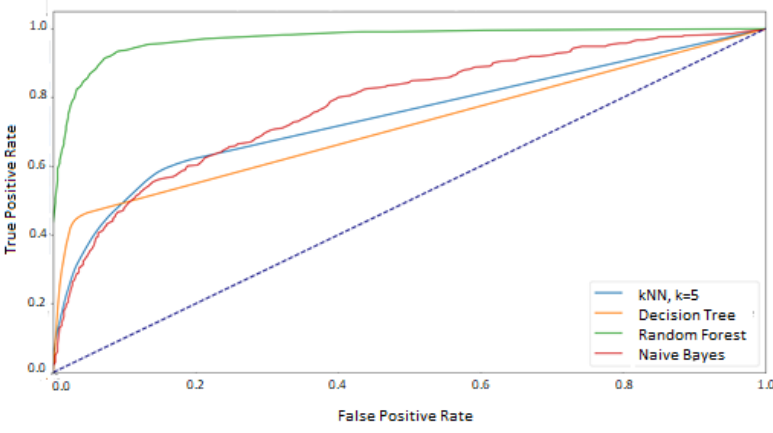
Figure 8. ROC–macro averages. The train and test sets based on the mixed sessions.